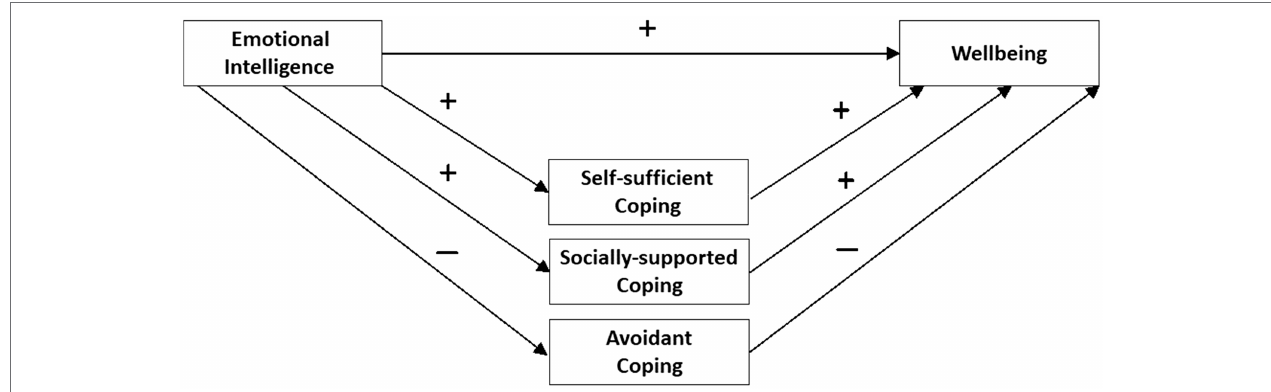
FIGURE 1 | Hypothesized path values when testing a mediation model where coping strategies mediate the effect of EI on well-being outcomes. Signs on the paths indicate the expected directions of the